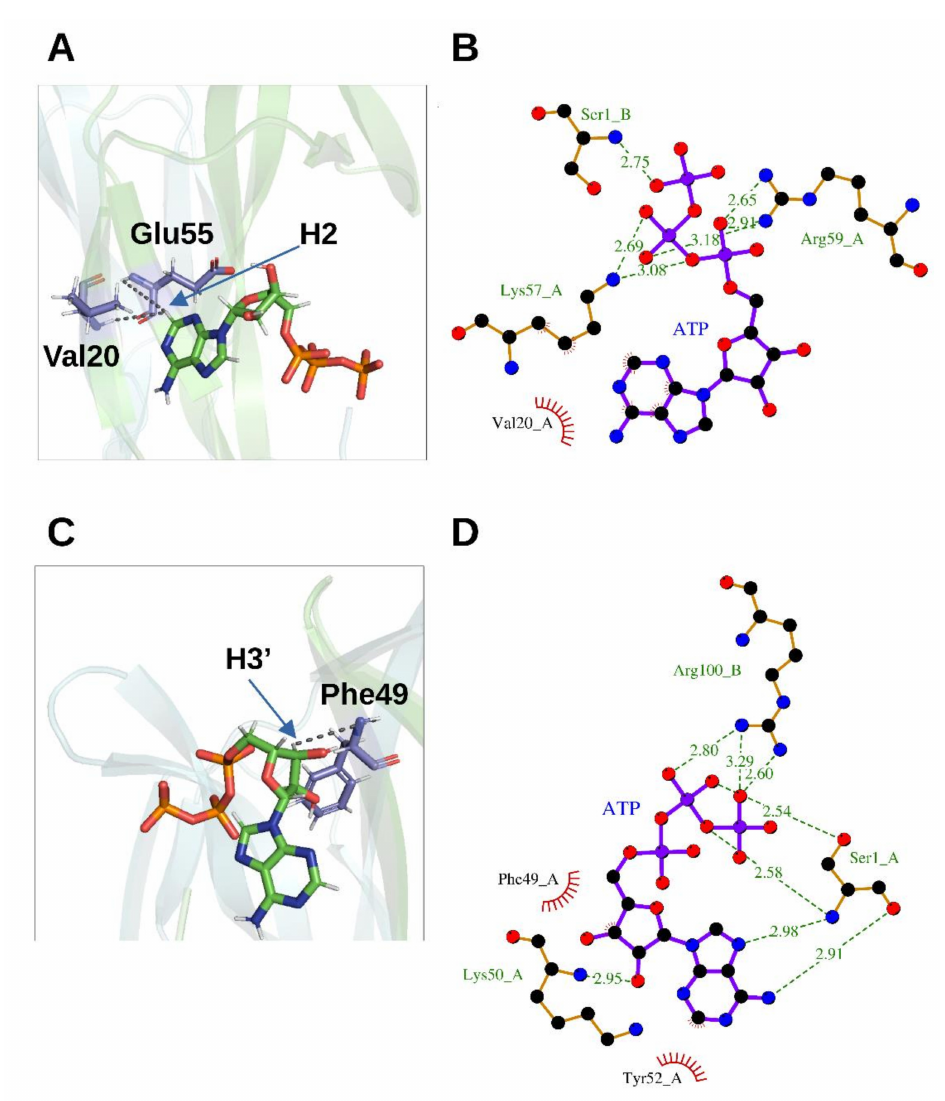
Figure 4. Binding orientation of ATP on rhNGF. ( A , C ) Representative poses from MD analysis for Site 1 ( A ) and Site 2 ( B ). Cyan and green transparent cartoon: rhNGF protomers; ATP is represented as colored by element (C—green; N—blue; O—red; H—white; P—orange). Residues V20, E55 and F49 showing new NOEs upon ATP binding are labelled and colored by element (C—violet; N—blue; O—red; H—white). Black broken lines represent the distances between HN protons of rhNGF and ATP protons (indicated by a blue arrow). Figures produced using PyMOL [28]. ( B , D )—Binding sites of rhNGF complexed with ATP for Site 1 ( B ) and Site 2 ( D ), respectively. The ligands and protein side chains are shown in ball-and-stick representation, with the ligand bonds colored in purple. Hydrogen bonds are shown as green dotted lines, while the spoked arcs represent protein residues making nonbonded (hydrophobic) contacts with the ligand. The 2D ligand–protein interaction diagrams have been produced with LigPlot+